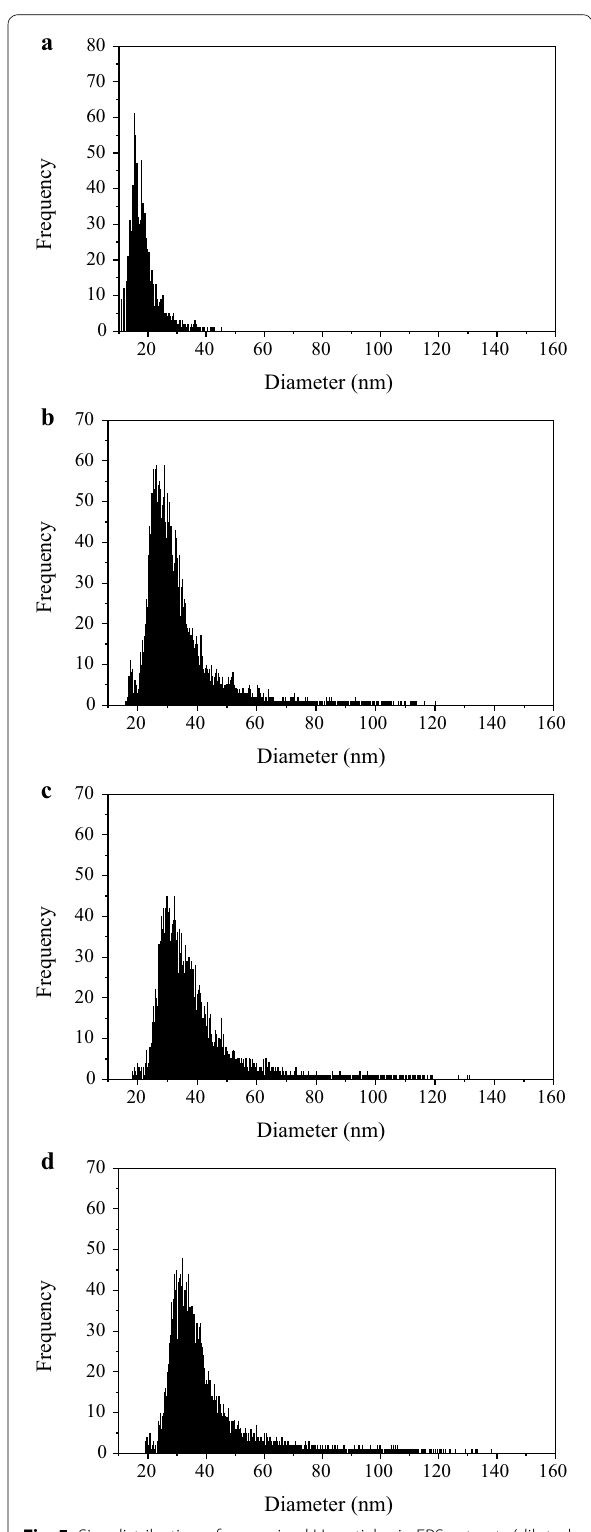
Fig. 5 Size distribution of nano‑sized U particles in EPS extracts (diluted 200 times, each frequency equals to particle concentration of about 21.2 parts per mL). a Original sludge, Day 0; b Day 3; c Day 5; d Day 7. Influent concentration of U(VI) was 50 mg/L and no acetate was